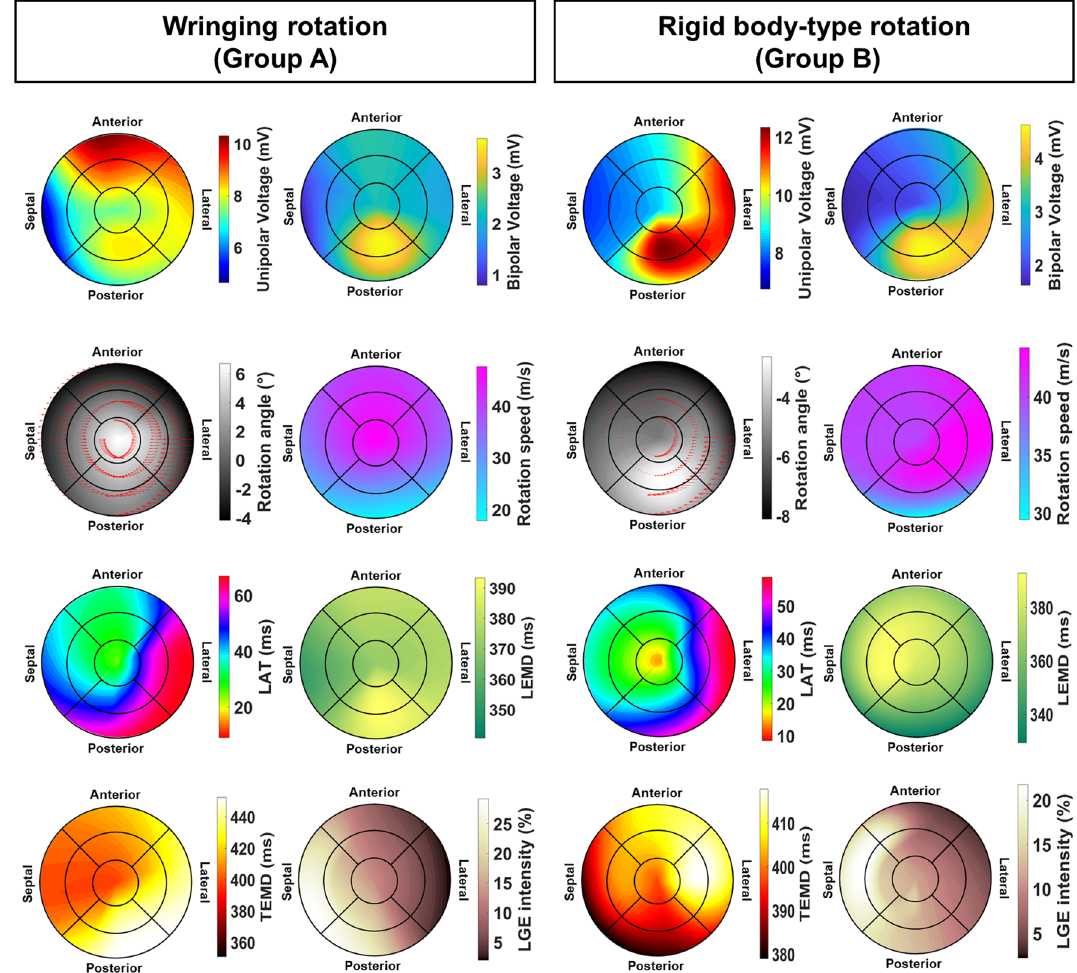
Figure 4. High-resolution aggregated maps of parameters of interest for the kinematic groups individuated, LV wringing rotation (Group A) and LV rigid-body-type rotation (Group B). Maps are oversampled by a factor 100 from the original nine segments with a spline function. LAT local activation time, LEMD local electro- mechanical delay, TEMD total electro-mechanical